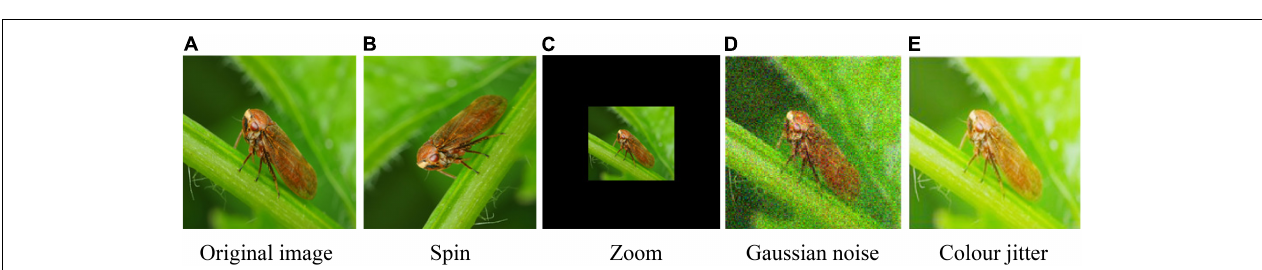
FIGURE 6 | Sample images for 10 common pest classes.